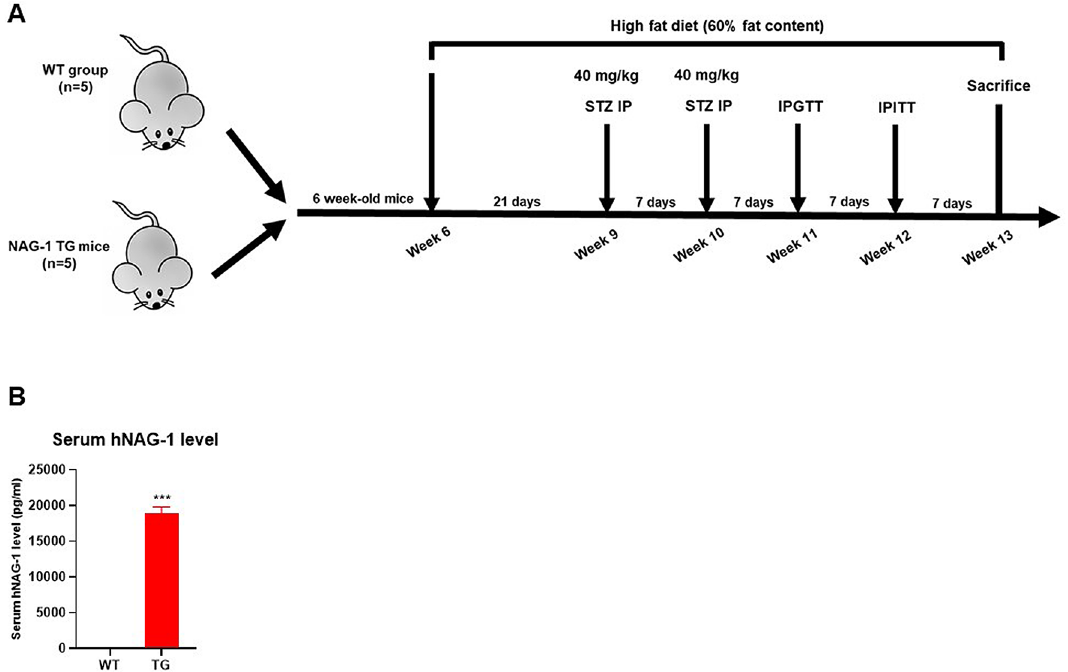
Figure 1. ( A ) Schematic diagram representing the timeline for experiments using the diabetes mouse model. NAG-1-overexpressing transgenic (n = 5) and wild-type (n = 5) male mice were fed with high-fat diet throughout the experiment. The mice were administered low-dose streptozotocin at weeks 9 and 10. Individual mice with blood sugar levels of > 200 mg/dL were considered to be animals with type 2 diabetes mellitus. ( B ) ELISA assay for human NAG-1 level in mouse serum. Data are presented as mean ± standard error, ***p < 0.01, compared with the wildtype